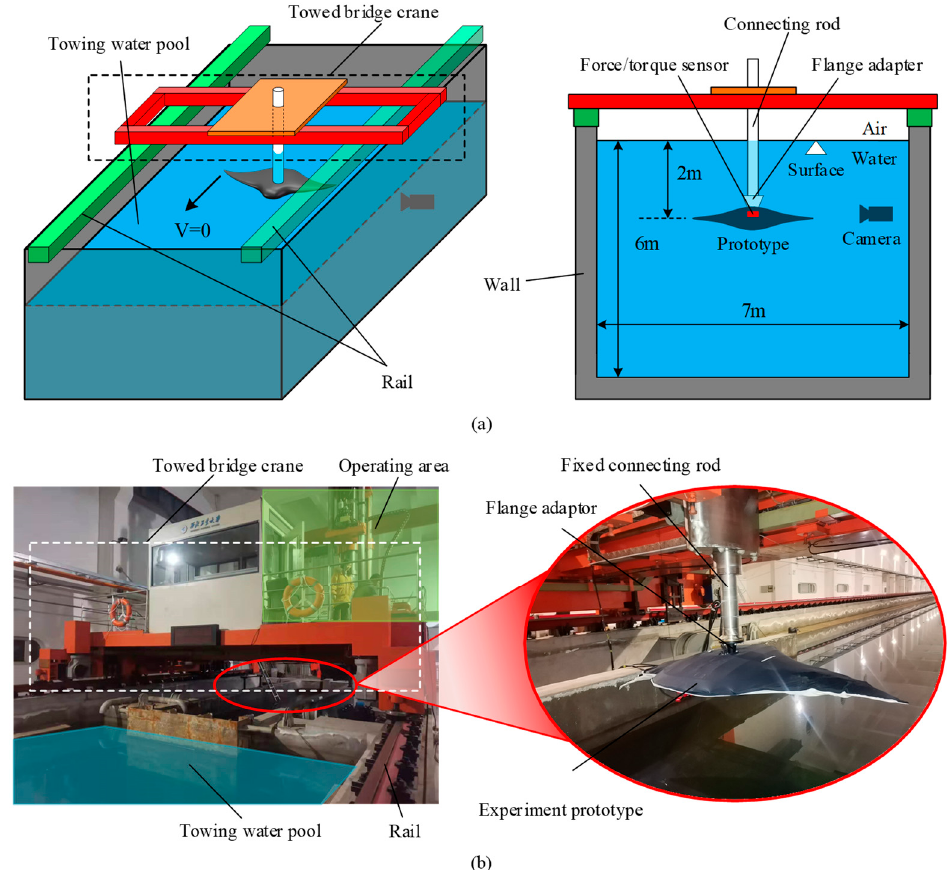
Figure 6. The composition of the experimental system. ( a ) The composition of the towing water pool and the installation diagram of the experimental prototype. ( b ) The actual experiment scene.